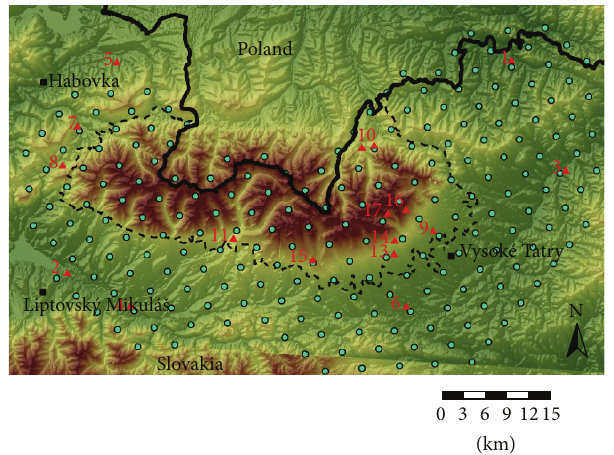
Figure 2: Localization of the used meteorological stations is depicted by triangles with number. Number near triangle corre- sponds to ID number of the station from Table 1. Circles represent grid points used in the GIS spatial analyses. Dashed line represents border of the Tatra National Park. Solid line depicts national